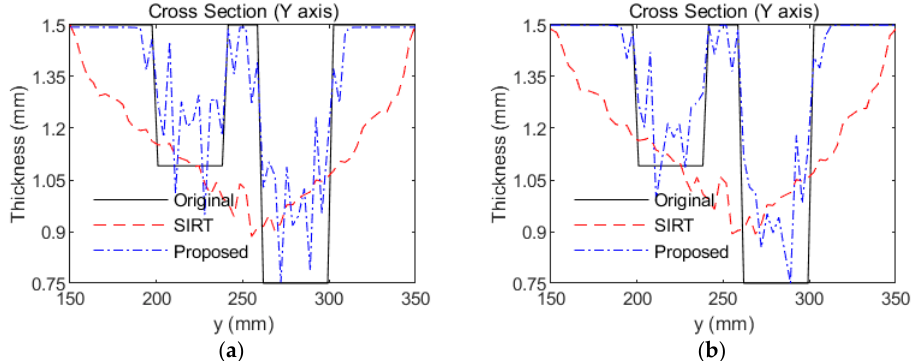
Figure 9. Cross-sections of the reconstructions of two circular flat-bottomed holes along the line that is marked in Figure 7. ( a ) SIRT and our method without temperature compensation and ( b ) SIRT and our method with temperature compensation.